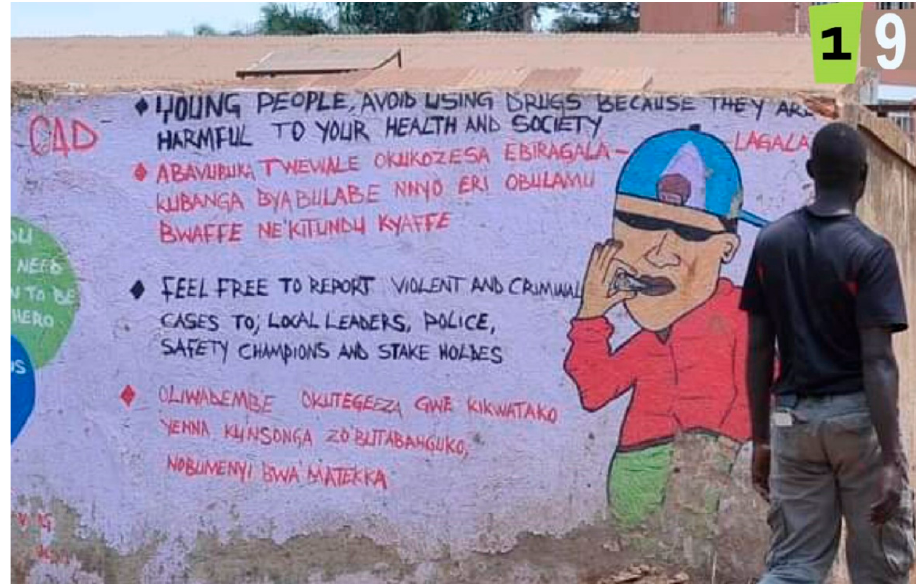
Figure 6. Mural Prevention Message (photo number 19). One photo depicted all three emotions and reflected a young woman with child shopping for food (Figure 7).